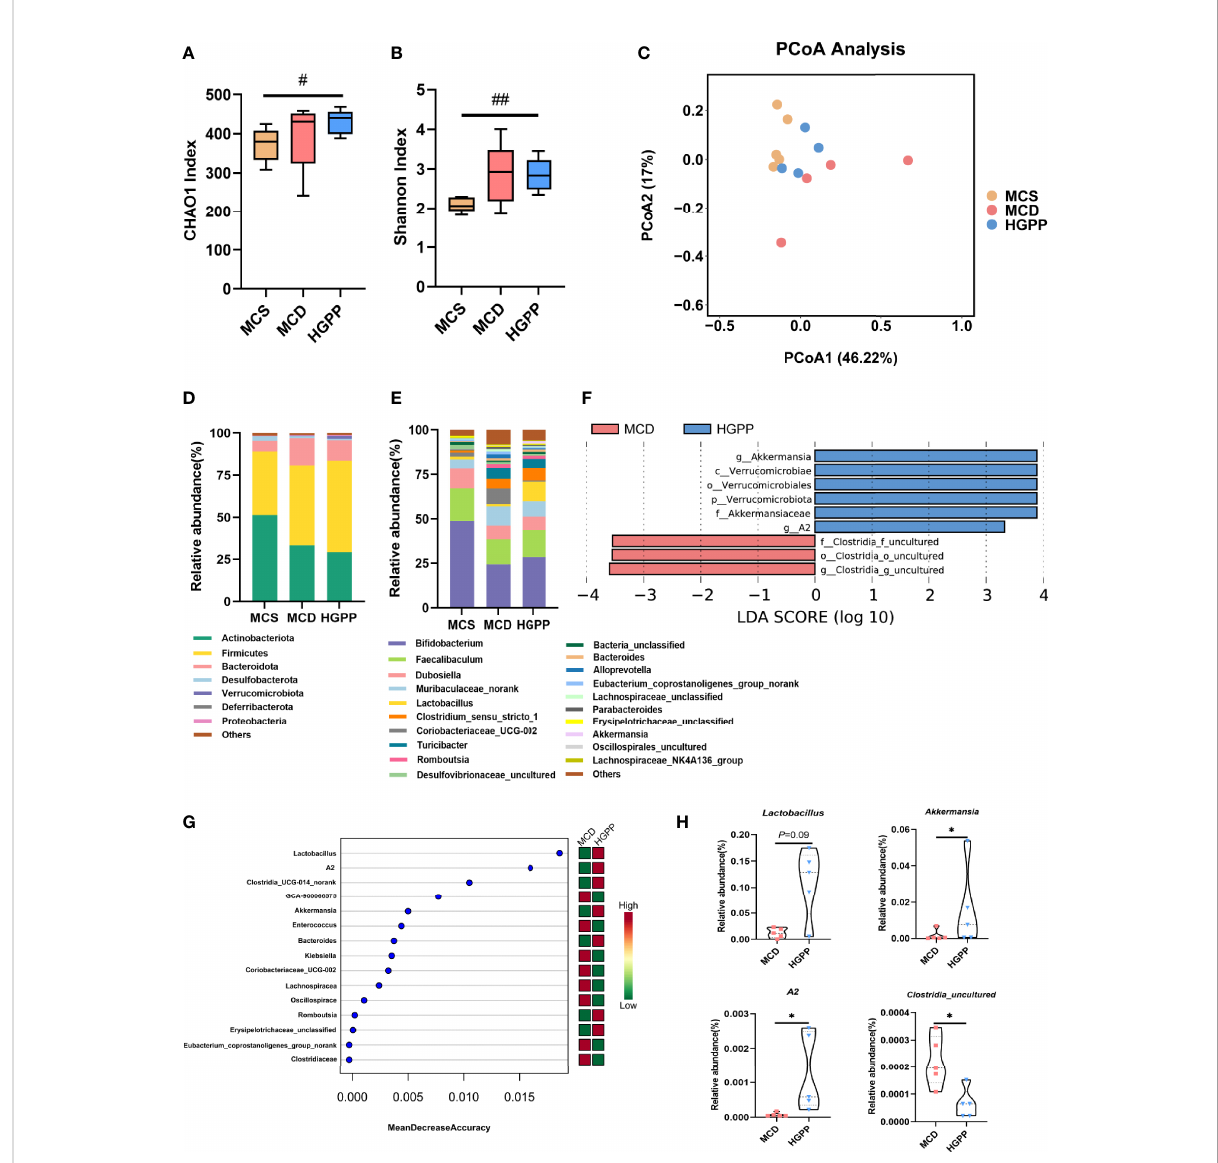
FIGURE 3 HGPP changed the composition of the gut microbiota. (A) The alpha diversity analysis, including CHAO1 diversity and (B) Shannon diversity (n = 4 – 5). (C) Principal coordinate analysis (PCoA) based on the Bray – Curtis of mouse colon content microbiota in MCS, MCD, and HGPP groups (n = 4 – 5). (D) Changes in colonic bacterial composition (relative abundance) at the phylum level (n = 5) and (E) genus level (n = 5). (F) Linear discriminant analysis (LDA) effect size (LEfSe) analysis for differential abundant taxa detected between MCD and HGPP groups based on the abundance pro fi les. Threshold parameters were set as P = 0.05 for the Mann – Whitney U test. LDA score > 2.0 (n = 5). (G) Top 15 bacterial genera in fl uencing mean decreased accuracy of random forest classi fi cation between MCD and HGPP colonic microbiota (n = 5). (H) The relative abundance of Lactobacillus , Akkermansia , A2 , and Clostridia_uncultured between MCD and HGPP groups (n = 5). Data are expressed as median and interquartile range (IQR)Please revise: * P <0.05, vs. the MCD group; # P <0.05 and ## P < 0.01 vs. the MCS group. Kruskal – Wallis test (A, B), Mann – Whitney U test (H)